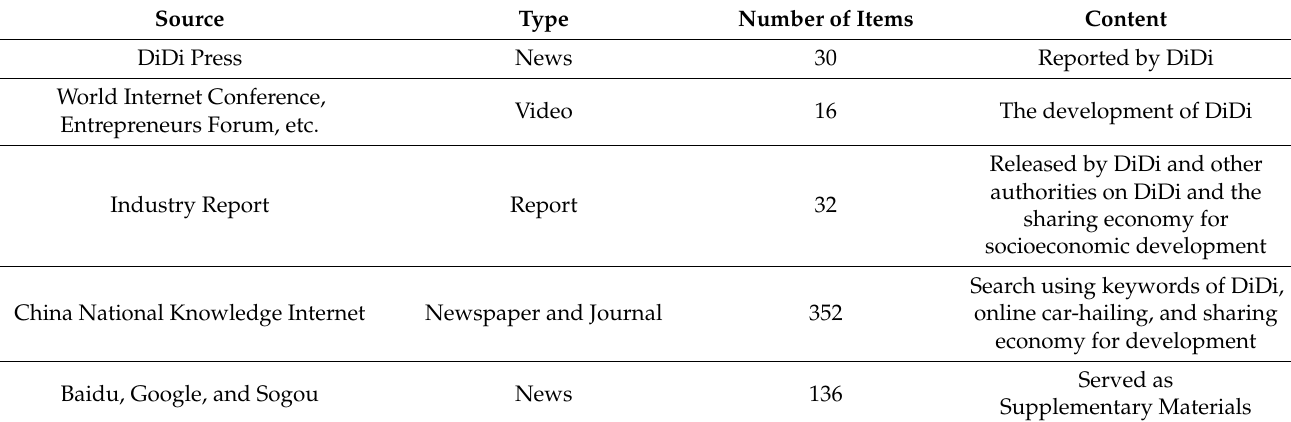
Table 1. Source of Research